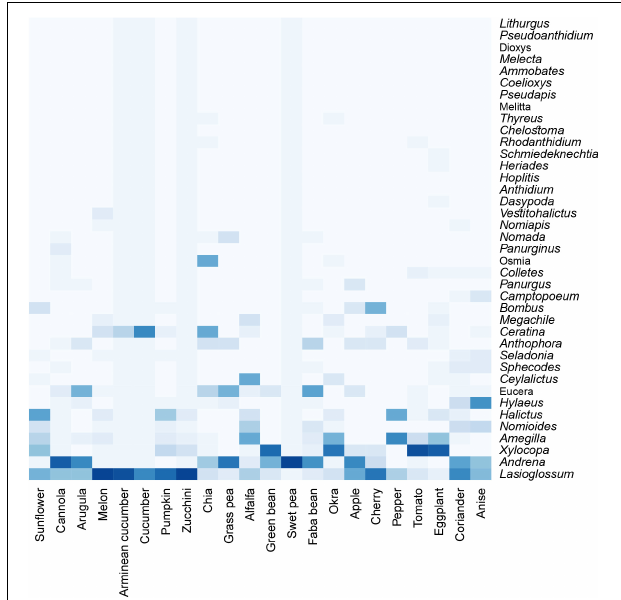
FIGURE 3 | Heatmap showing bee genera visiting each crop. Darker blue represents high